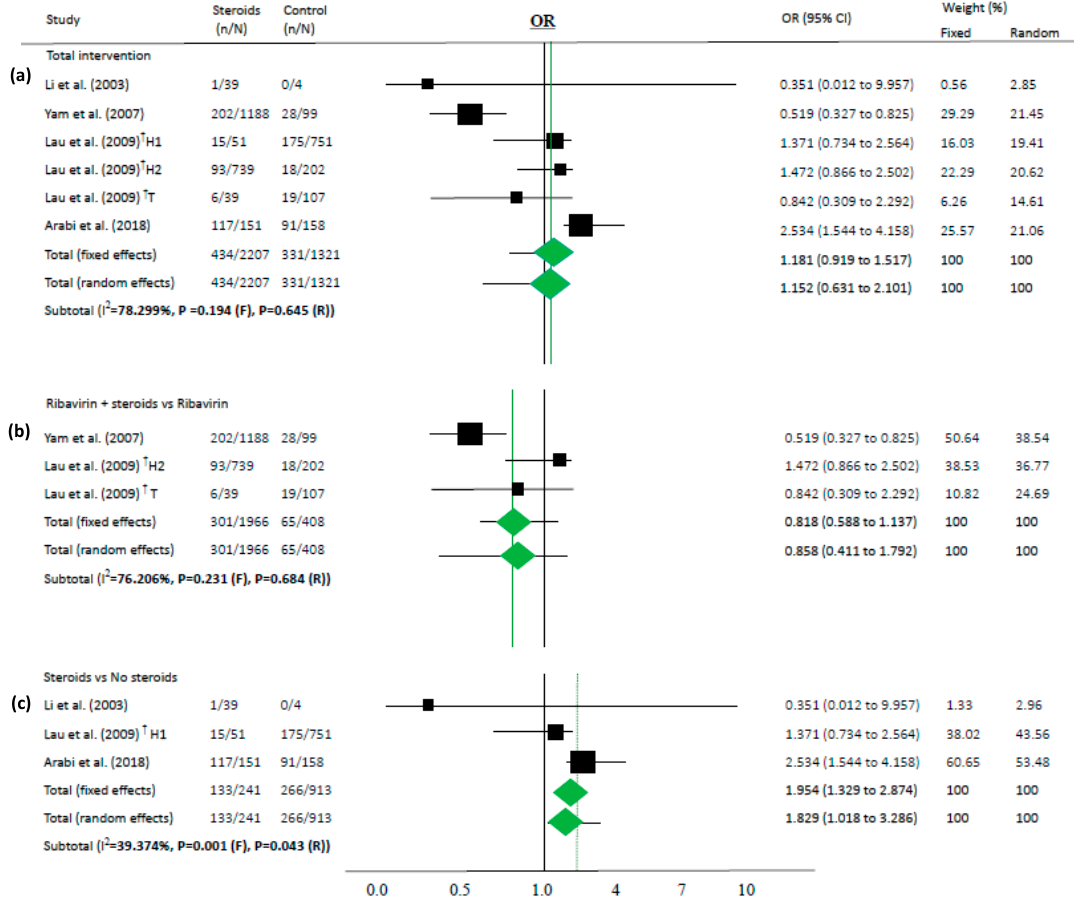
Figure 2. Association between steroids and mortality of studies about “intervention”. Studies are presented as country study (study [year]). The data are presented for total intervention ( a ), steroids as an add-on therapy for ribavirin ( b ), and steroids itself comparing the non-steroid group ( c ). † These are the same as the paper (Lau (2009) [34]) that has two subgroups: one study conducted in Hong-Kong (H1 and H2) and the other study in Toronto (T).